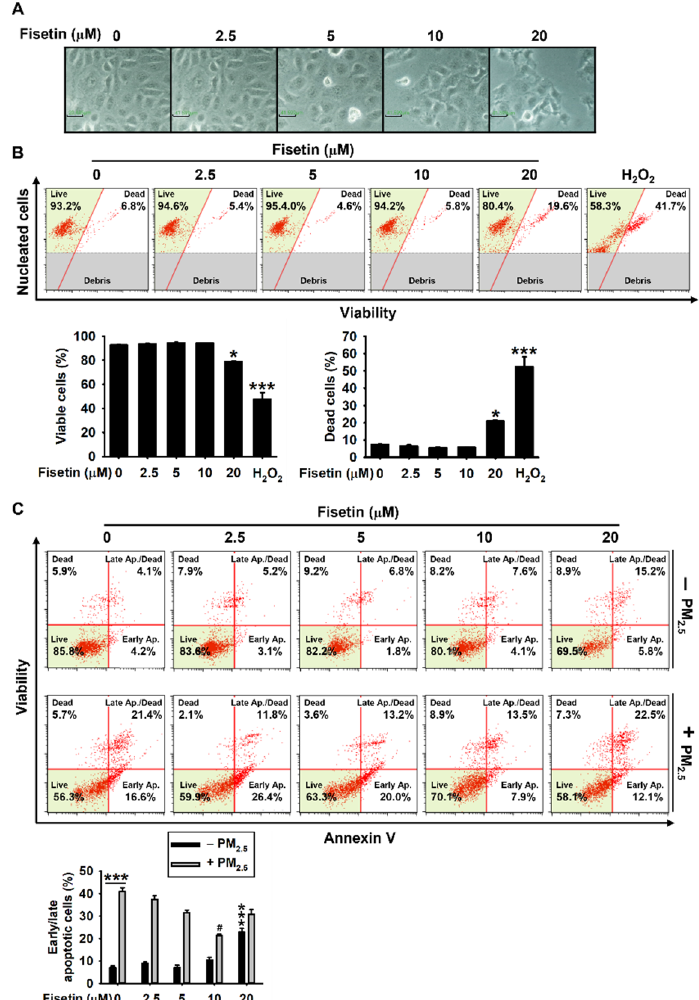
Figure 1. Fisetin protects HaCaT keratinocytes against PM 2.5 -induced apoptosis. The HaCaT keratinocytes were treated with fisetin (0–20 μ M) for 24 h. ( A ) Morphological changes were observed by phase-contrast microscopy (10 × ). Scale bar = 40 µ m. ( B ) Cell viability was measured using a Muse Count & Viability Kit. Graphical representation of the population of viable ( bottom left ) and dead cells ( bottom right ). ( C ) The cells were pretreated with fisetin (0–20 µ M) for 2 h prior to exposure to 100 µ g/mL PM 2.5 for 24 h. Apoptosis was measured using a Muse Annexin V & Dead Cell Assay Kit. Graphical representation of the population of early/late apoptotic cells ( bottom ). *** p < 0.001 and * p < 0.05 vs. untreated cells and # p < 0.05 vs. PM 2.5 -treated cells.